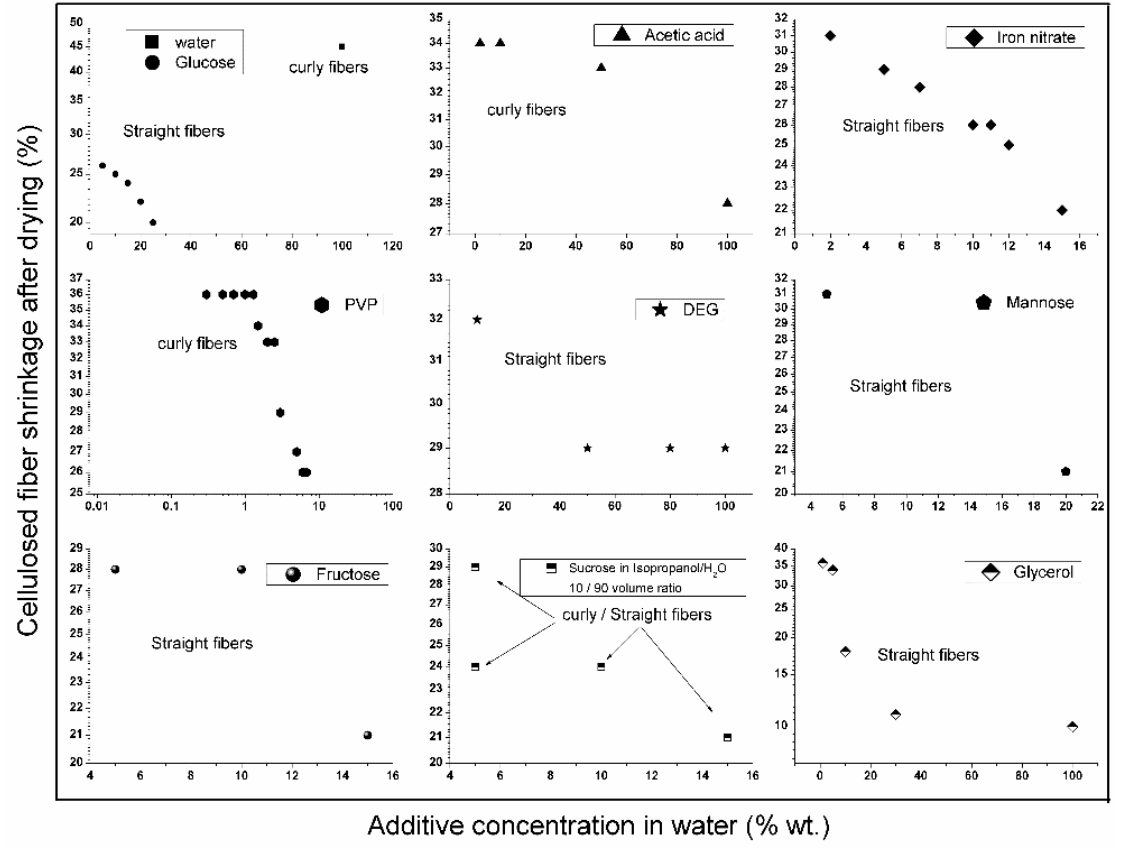
Figure A4. Effect of different additives (after deacetylation) on shrinkage of dried cellulose fibers.